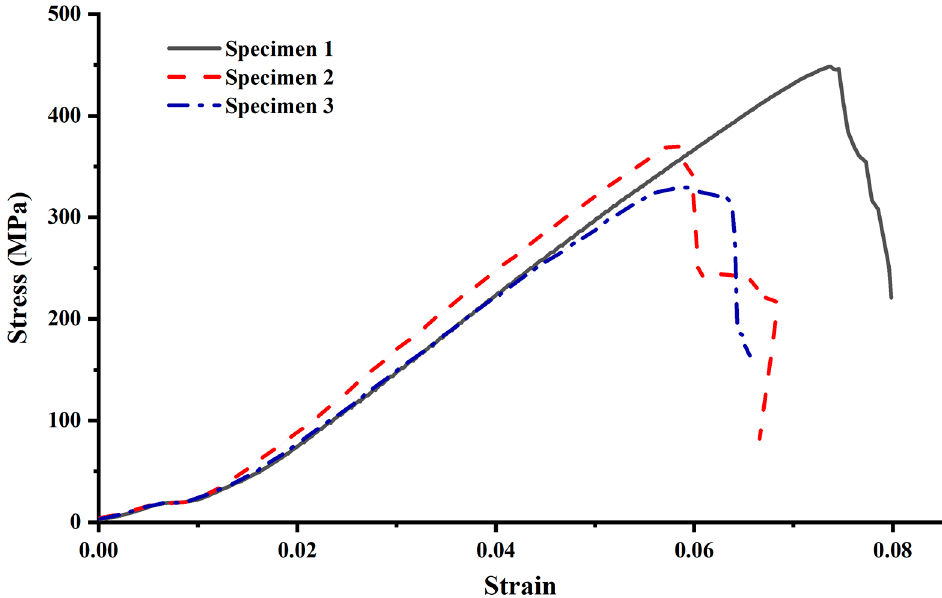
Figure 6. Stress-strain curves of GFRP bars.